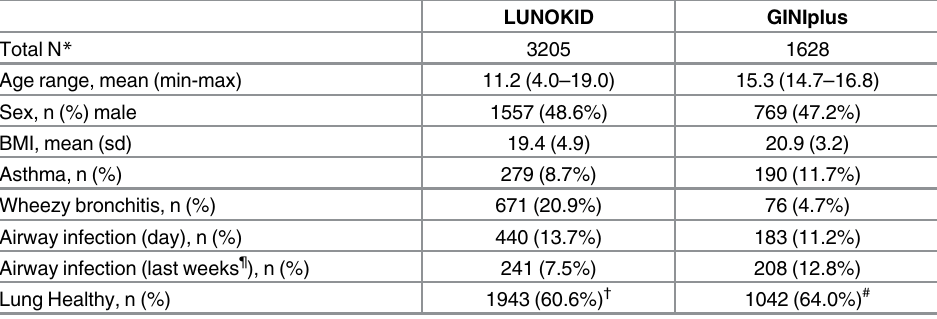
Table 1. Description of study populations (LUNOKID and